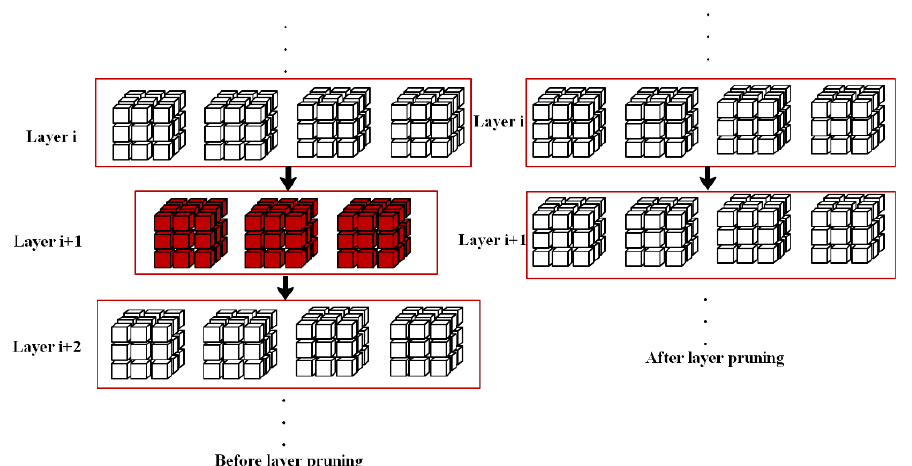
Figure 7. Before and after layer pruning.